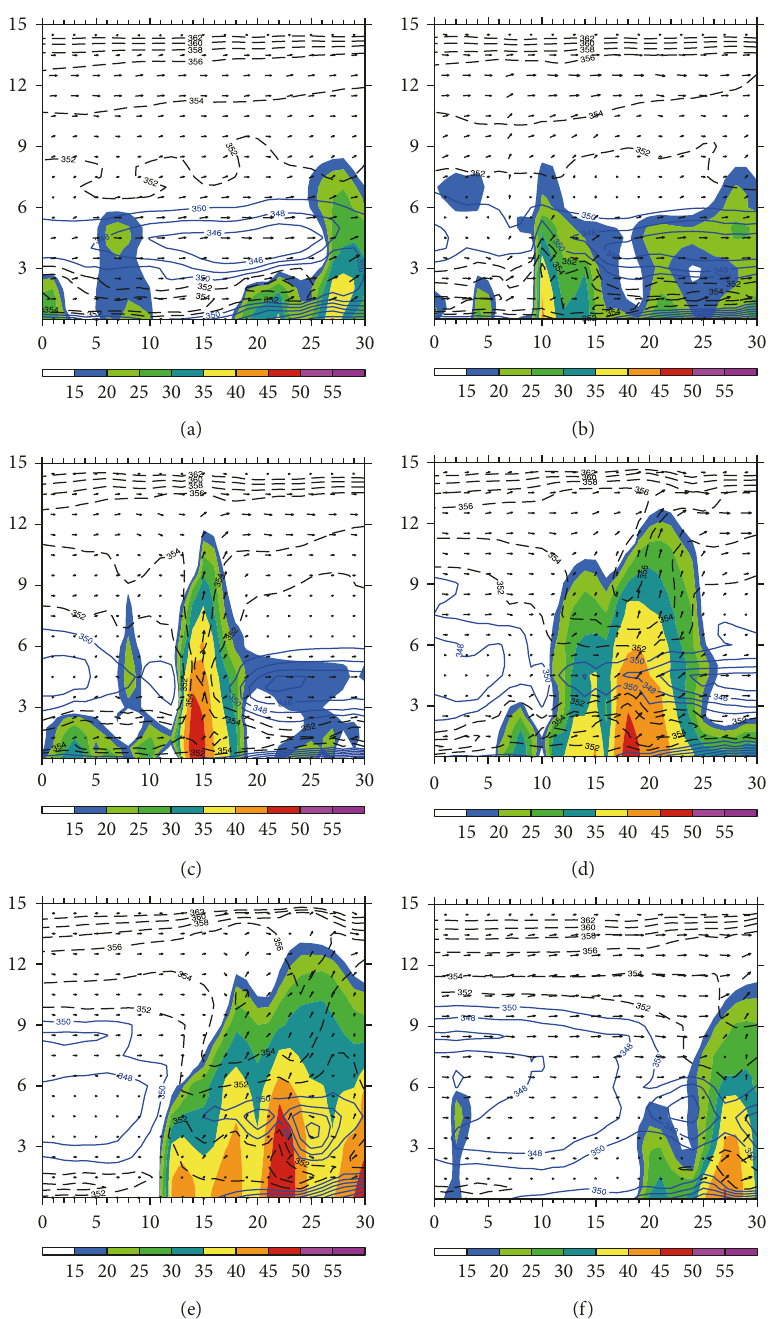
Figure 15: Vertical cross sections along EF (shown in Figure 2(a)) of radar echo (shadings, unit: dBZ), equivalent potential temperature (solid lines, unit: K blue lines for 350K and black lines for 350K), and winds at various times (a) 1400 UTC, (b) 1600 UTC, (c) 1700 UTC, (d) 1800 UTC, (e) 1900 UTC, and (f) 2100 UTC. Y -axis indicates the height (unit: km). X -axis shows the distance along the direction shown by BD in Figure 2(a) to the western boundary (AB) of the key rainstorm area (unit: ≤ >